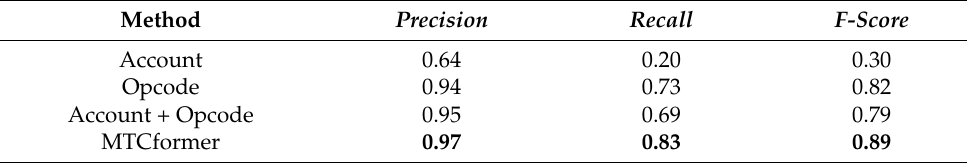
Table 1. The performance of different Ponzi scheme contract detection methods. Method Precision Recall F-Score Account 0.64